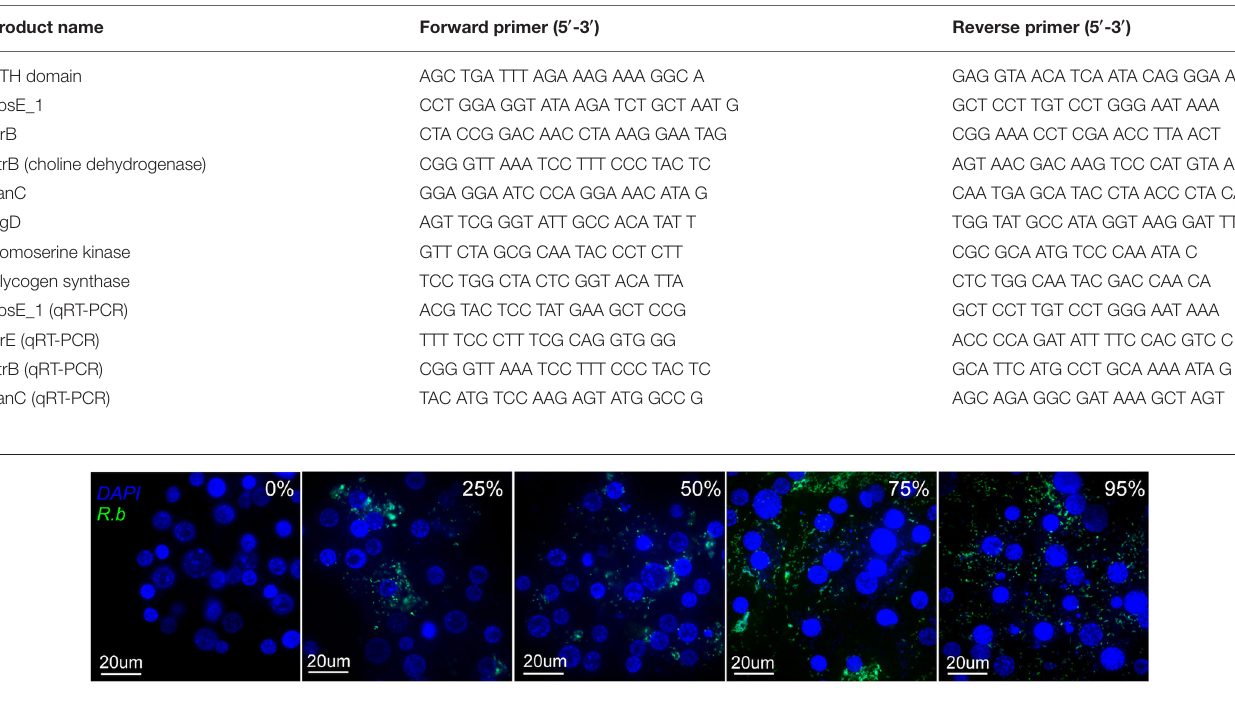
TABLE 1 | Primers used for the amplification of Rickettsia buchneri antibiotic cluster genes.